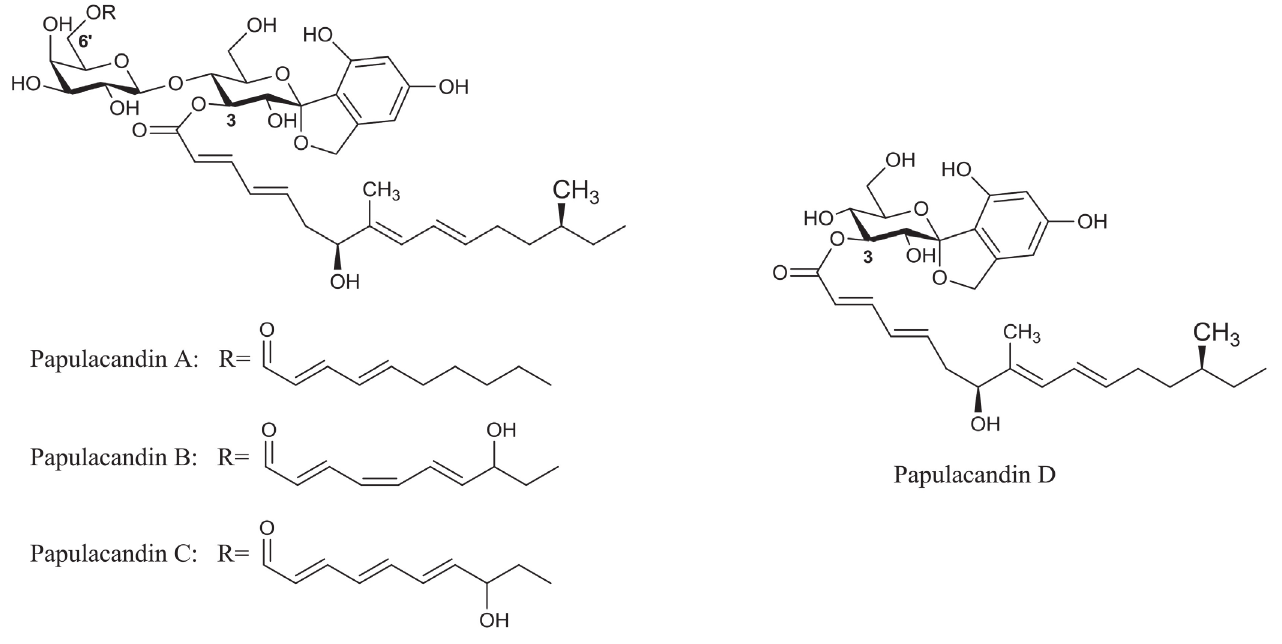
FIGURE 1 - Chemical structures of